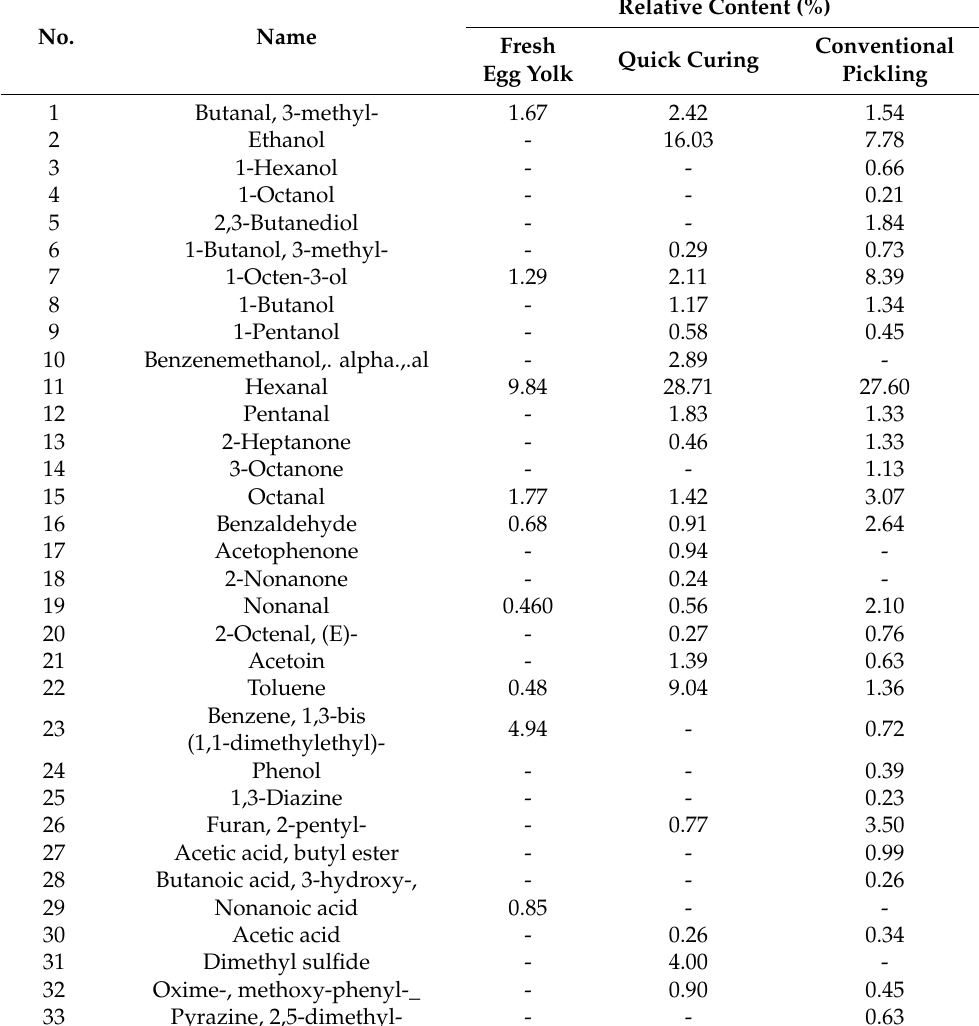
Table 4. Analysis of volatile flavor components in salted egg